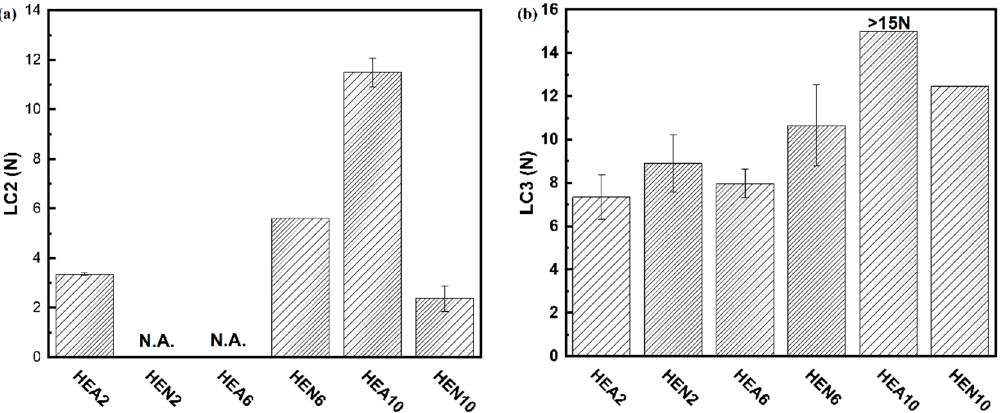
Figure 10. Plotted data on critical loads variation as function of sample characteristics: ( a ) LC2—the load necessary for the first delamination, and ( b ) LC3—the load responsible for total film removal.